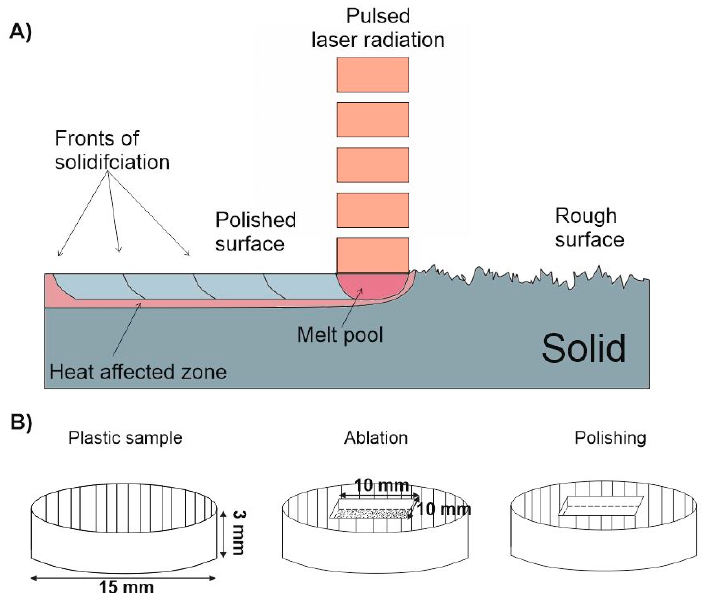
Figure 2. Laser polishing using pulsed laser radiation scheme ( A ), micromachining steps used for polishing ( B ). The structure of 10 mm × 10 mm × 0.5 mm was ablated and then polished using bursts of femtosecond pulses.